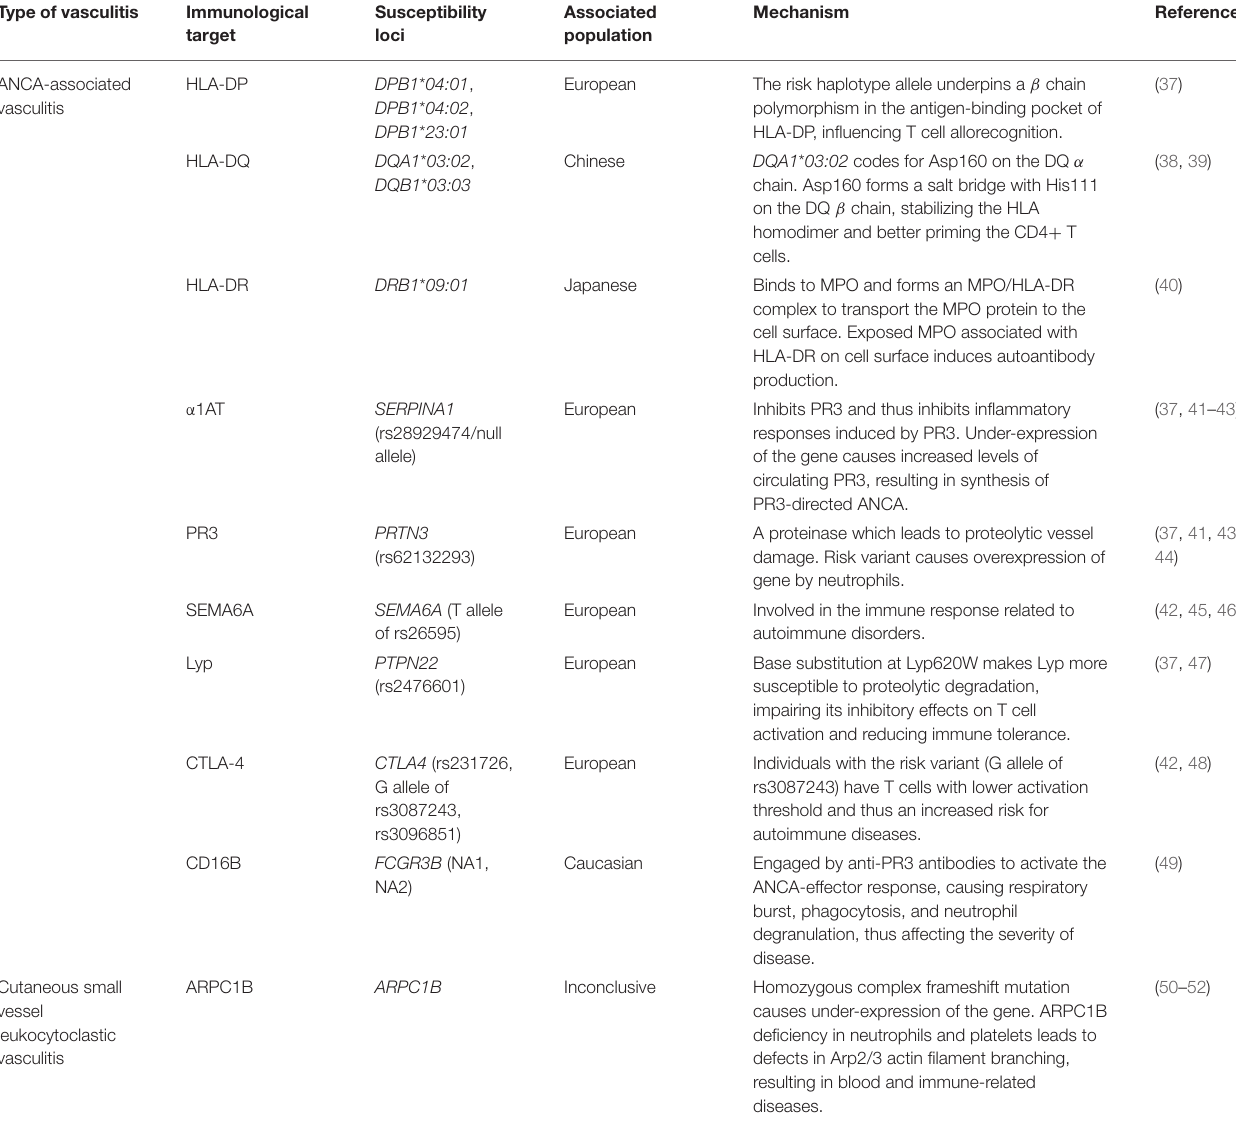
TABLE 1 | Relationship between vasculitis immunological mechanisms and susceptibility loci in different